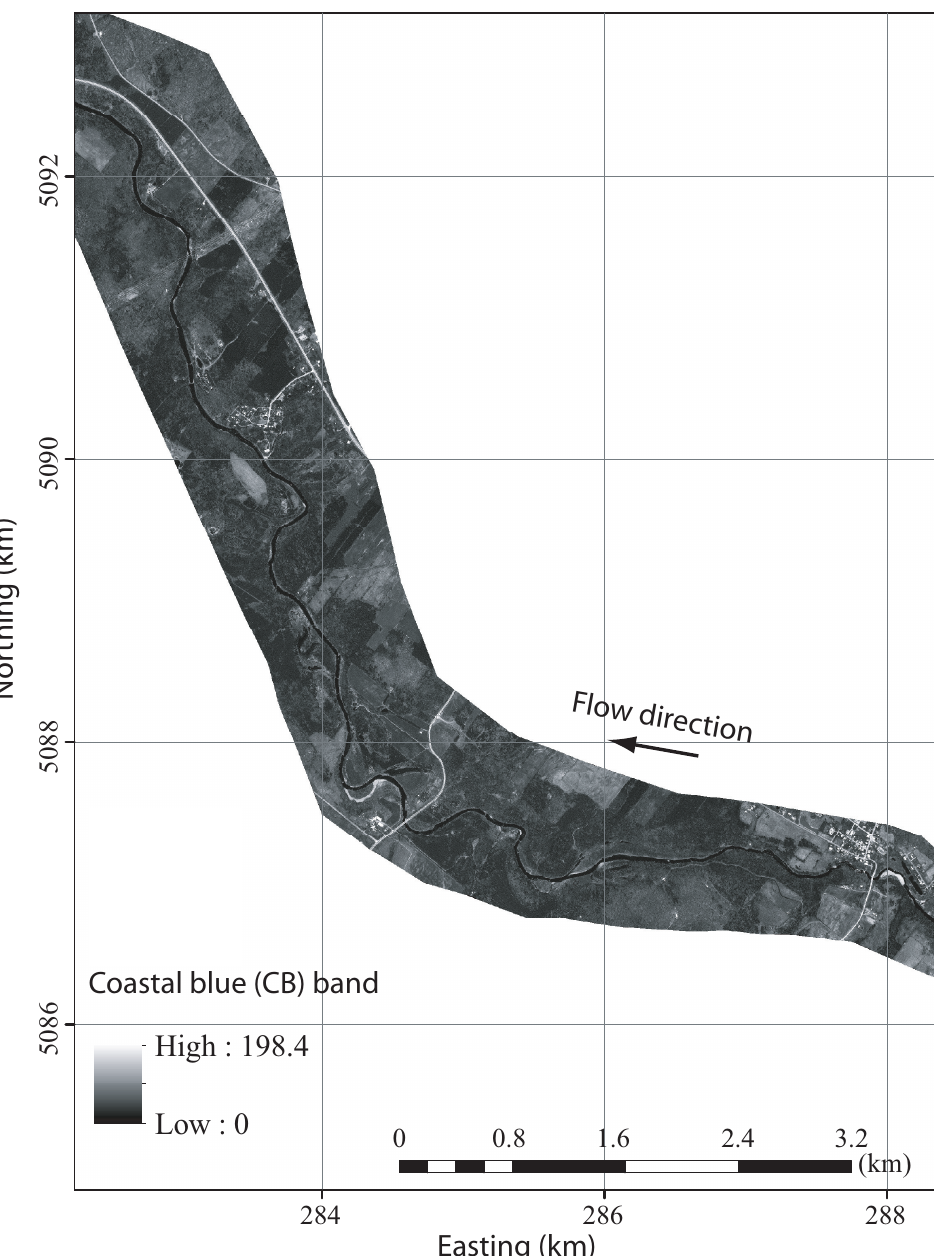
Figure A5. Corrected radiance in the coastal blue (CB)